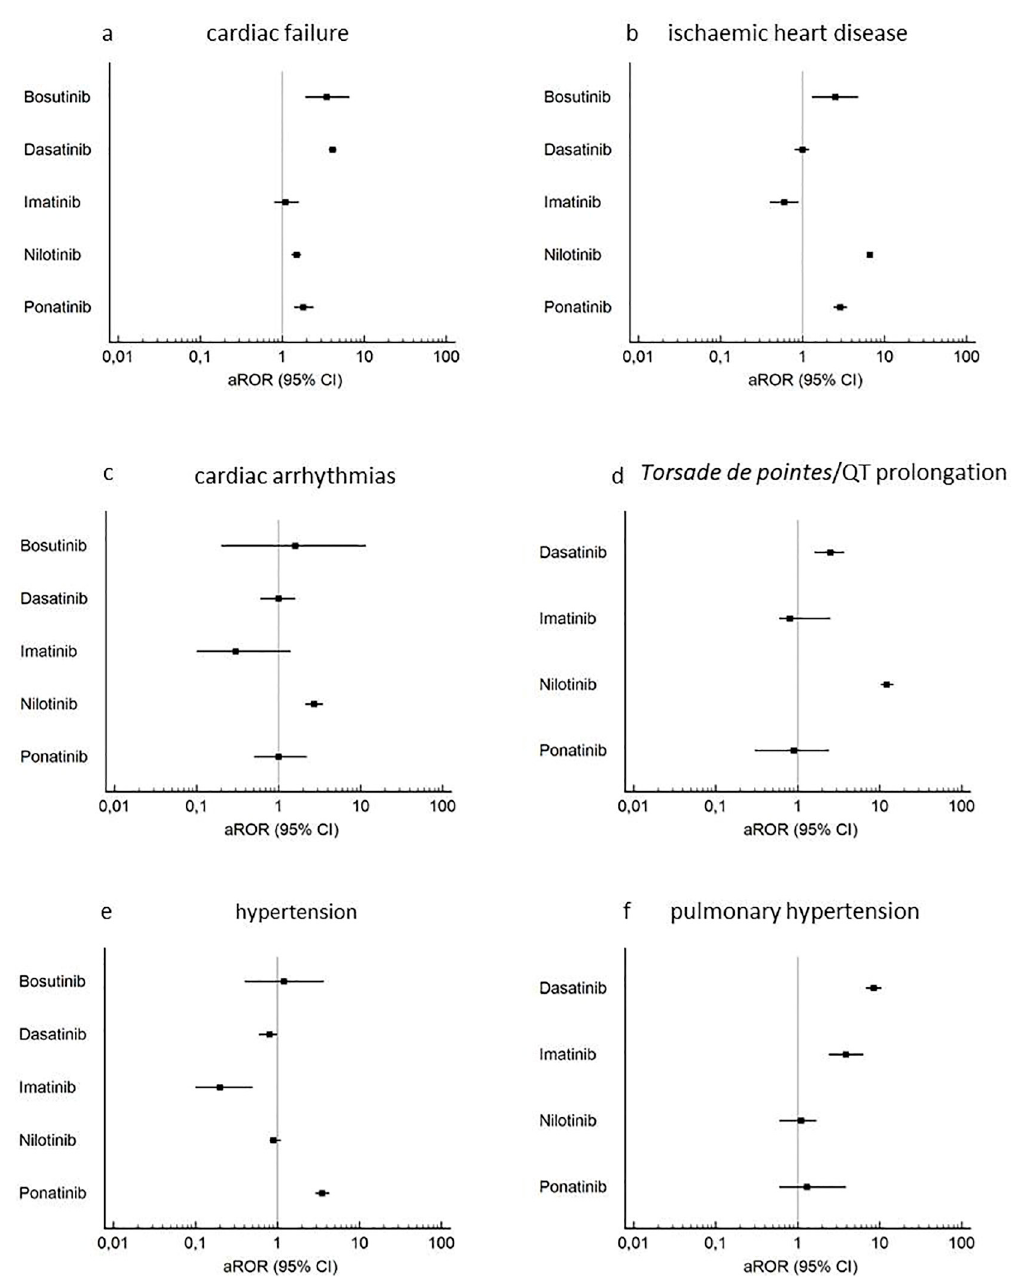
Figure 1. Forest plots of disproportionality (aROR) of TKIs and cardiovascular events.